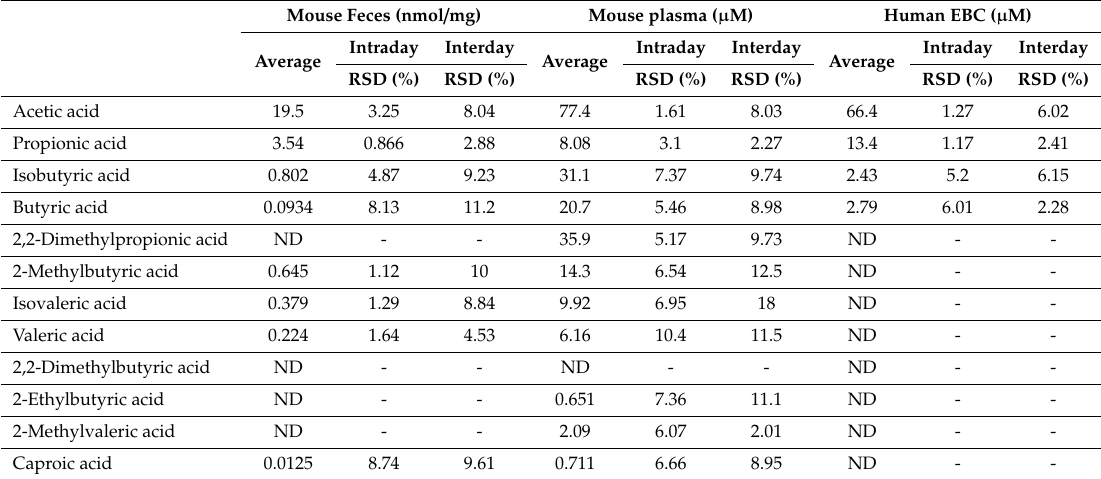
Figure 4. Stability of derivatized SCFAs in mouse feces. Sample solutions containing derivatized SCFAs were stored at 4 °C and measured on day 1, 5, and 7. Three measurements were performed on each day. Error bar represents the standard deviation of three measurements. Table 2. Average amounts of SCFAs in biological samples, and their intra- and inter-day reproducibilities. ND represents “not detected”. ( n = 3 for intra- or inter-day reproducibility) .